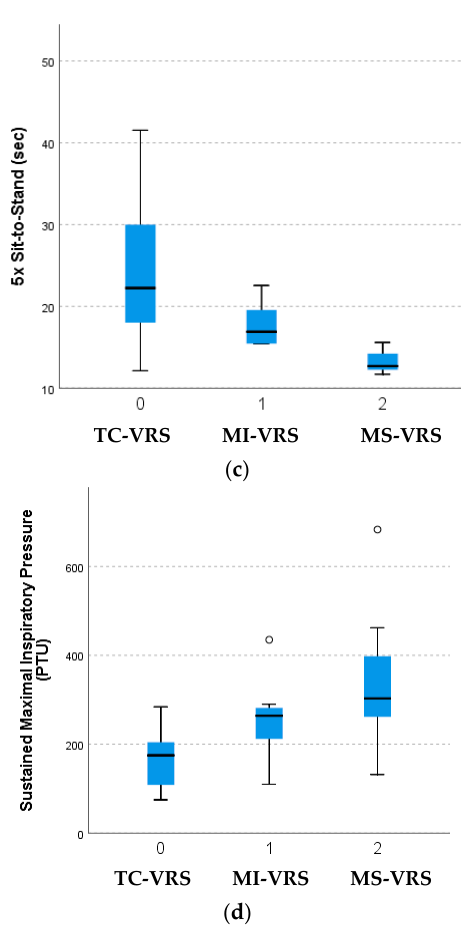
Figure 1. Key characteristics of valve replacement types. ( a ) Age of patients among the valve replacement types (VRS = valve replacement surgery; TC = transcatheter; MI = minimally invasive; MS = median sternotomy). ( b ) 6-min walk test performance of patients among the valve replacement types. (VR S= valve replacement surgery; TC = transcatheter; MI = minimally invasive; MS = median sternotomy). ( c ) 5x sit-to-stand performance of patients among the valve replacement types. (VRS = valve replacement surgery; TC = transcatheter; MI = minimally invasive; MS = median sternotomy). ( d ) Sustained maximal inspiratory pressure of patients among the valve replacement types. (VRS = valve replacement surgery; TC = transcatheter; MI = minimally invasive; MS = median sternotomy).